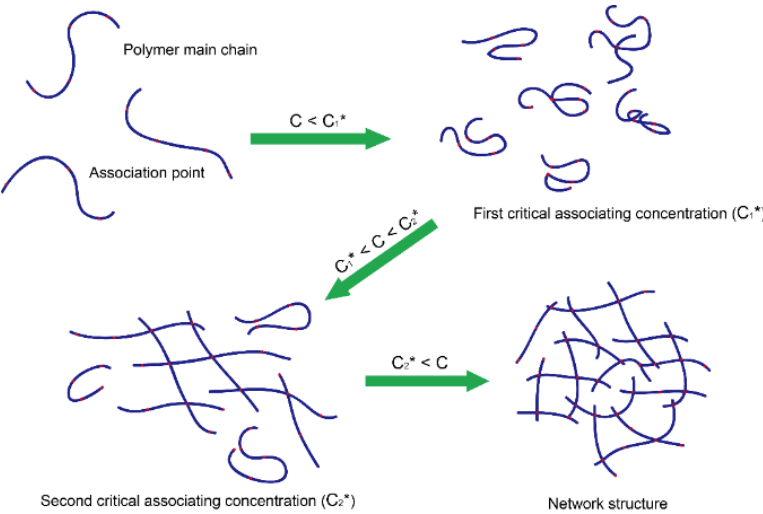
Figure 4. The association process for the copolymer solution in water.